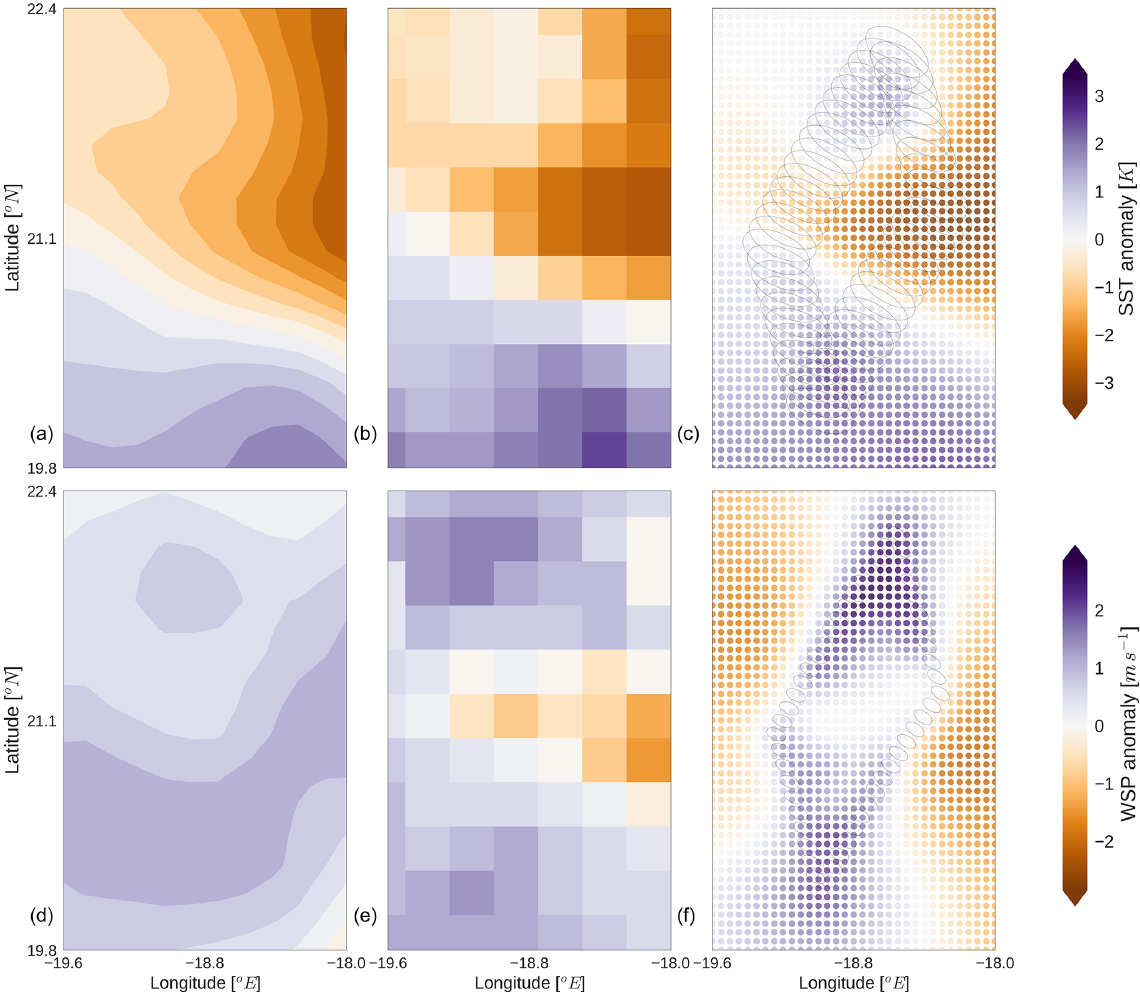
Figure 7. For the same scene as Fig. 6, the retrieved state vectors are compared for SST (c) and WSP (f) against ERA5 (a, d) and RSS (b, e) . Each is displayed as the anomaly from the mean of the entire field. In the right panels, FOVs for the 6 and 36GHz channels are shown for the pixels defining the edge of the observation